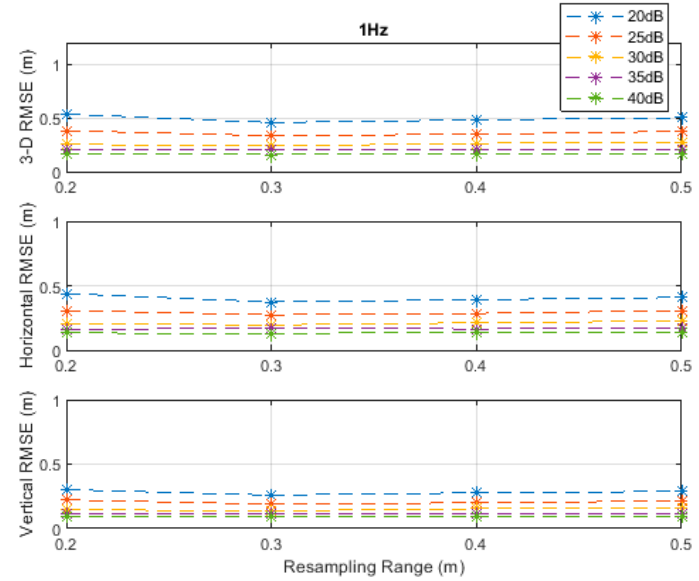
Figure 2. Root-mean-square error (RMSE) results along the 3D linear path at a measurement update rate of 1 Hz.